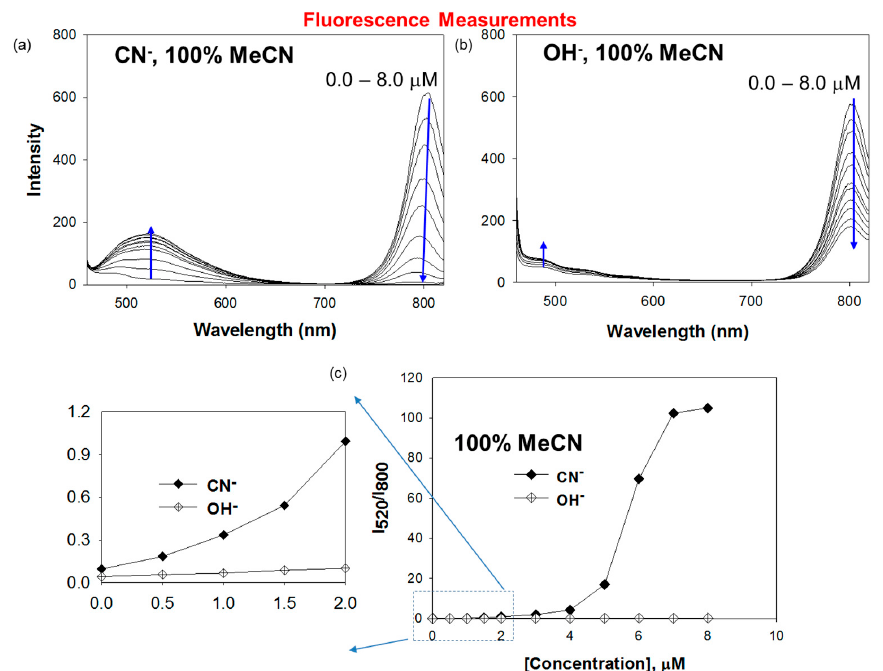
Figure 4. Fluorescence emission spectra ( λ ex = 430 nm, excitation slit = 20 nm, emission slit = 20 nm), for IR-786 (50 μ M) in 100% MeCN ( a ) CN − (up to 8 μ M) and ( b ) OH − (up to 8 μ M) and ( c ) fluorescence emission ratiometric values (intensity value at 520 nm divided by intensity value at 800 nm) obtained from (a). Arrows show the direction of increased amount of anions.